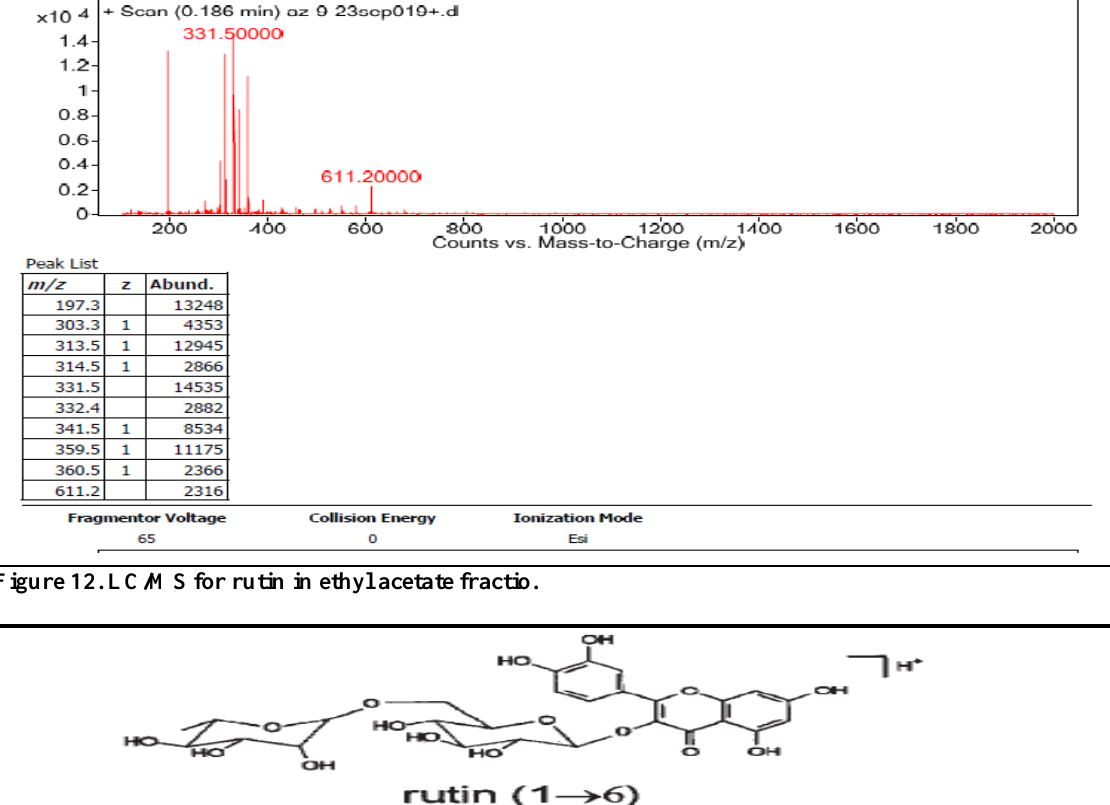
Figure 12. LC/MS for rutin in ethyl acetate fractio.